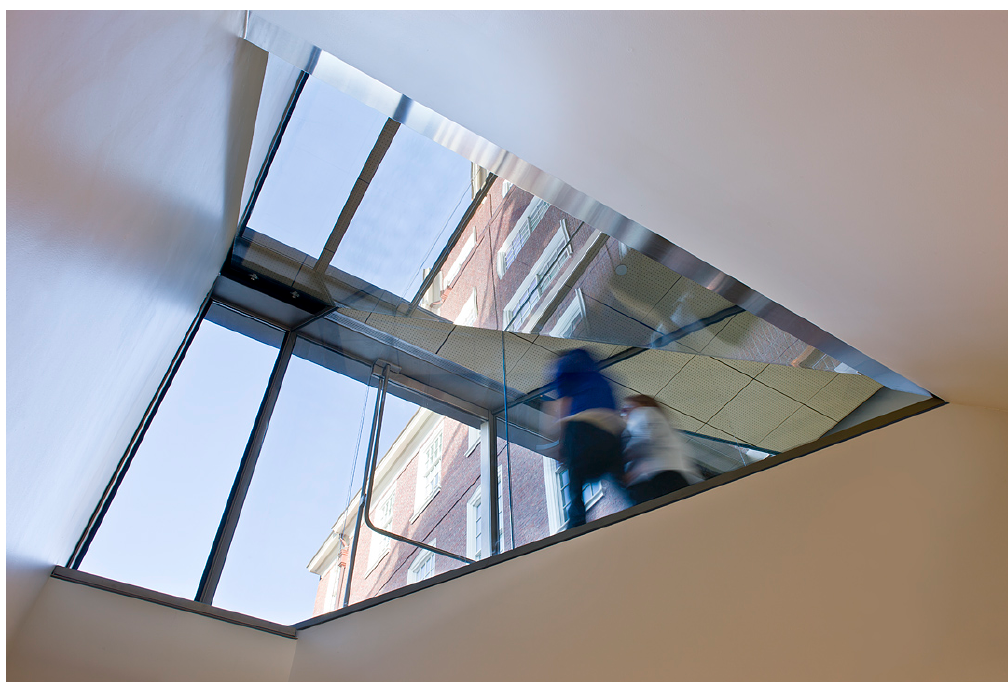
Fig. 5 P-131317, 2011 | Glass and existing architecture | Total dimensions variable Brown University Cognitive Science Building | Providence RI, USA Photo Credit: Warren Jagger | Interior view from basement